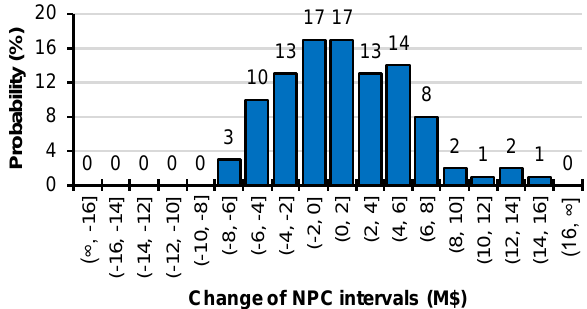
Figure 6. Probability distribution of absolutes changes for the net present cost (NPC).